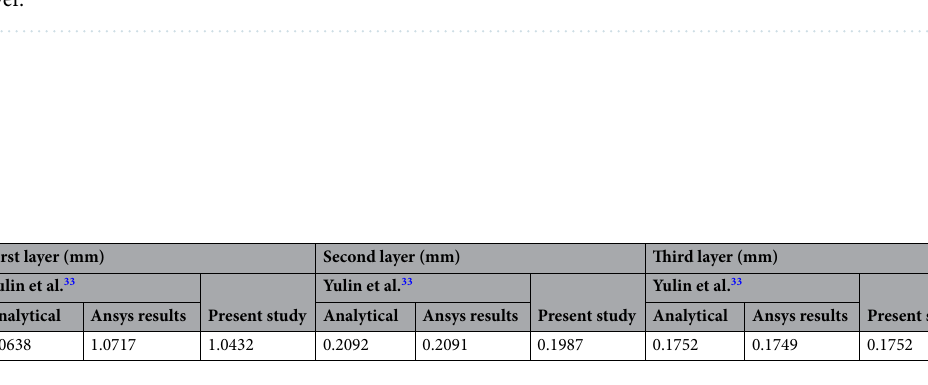
Table 2. Comparison of peak mid-span displacements of three-layer beam-spring system for moving speed of 32 m s −1 .